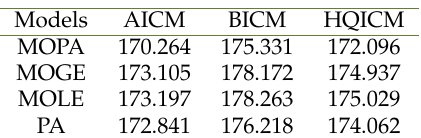
Table 3. The MLEs and their SEs in brackets for the Turbocharger data.